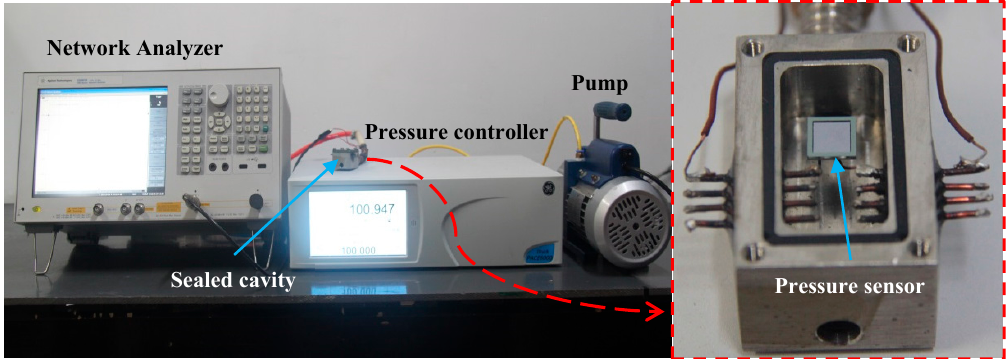
Figure 7. Frequency-pressure measurement system.